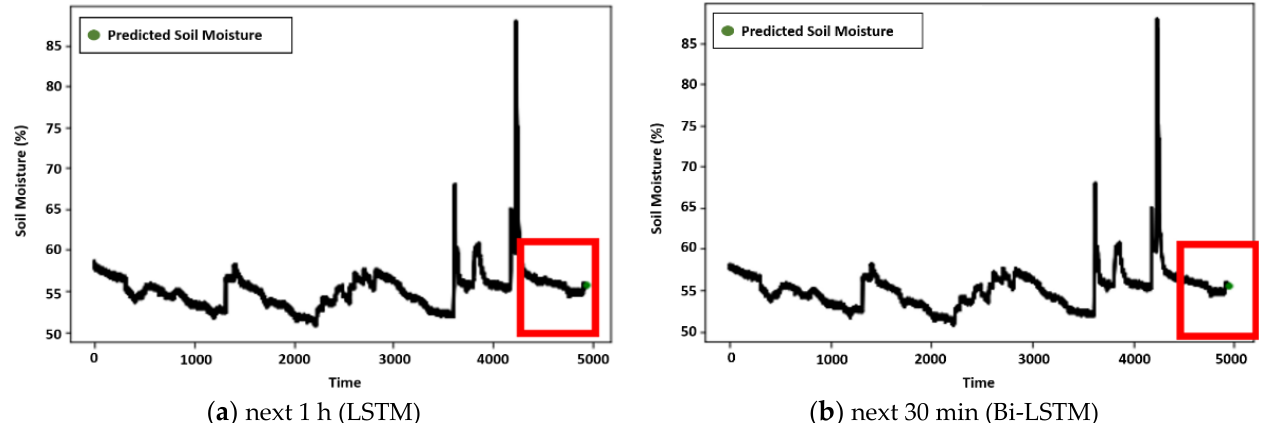
Figure 8. Result of soil moisture value forecasting for ( a ) the next 1 h and ( b ) the next 30 min.